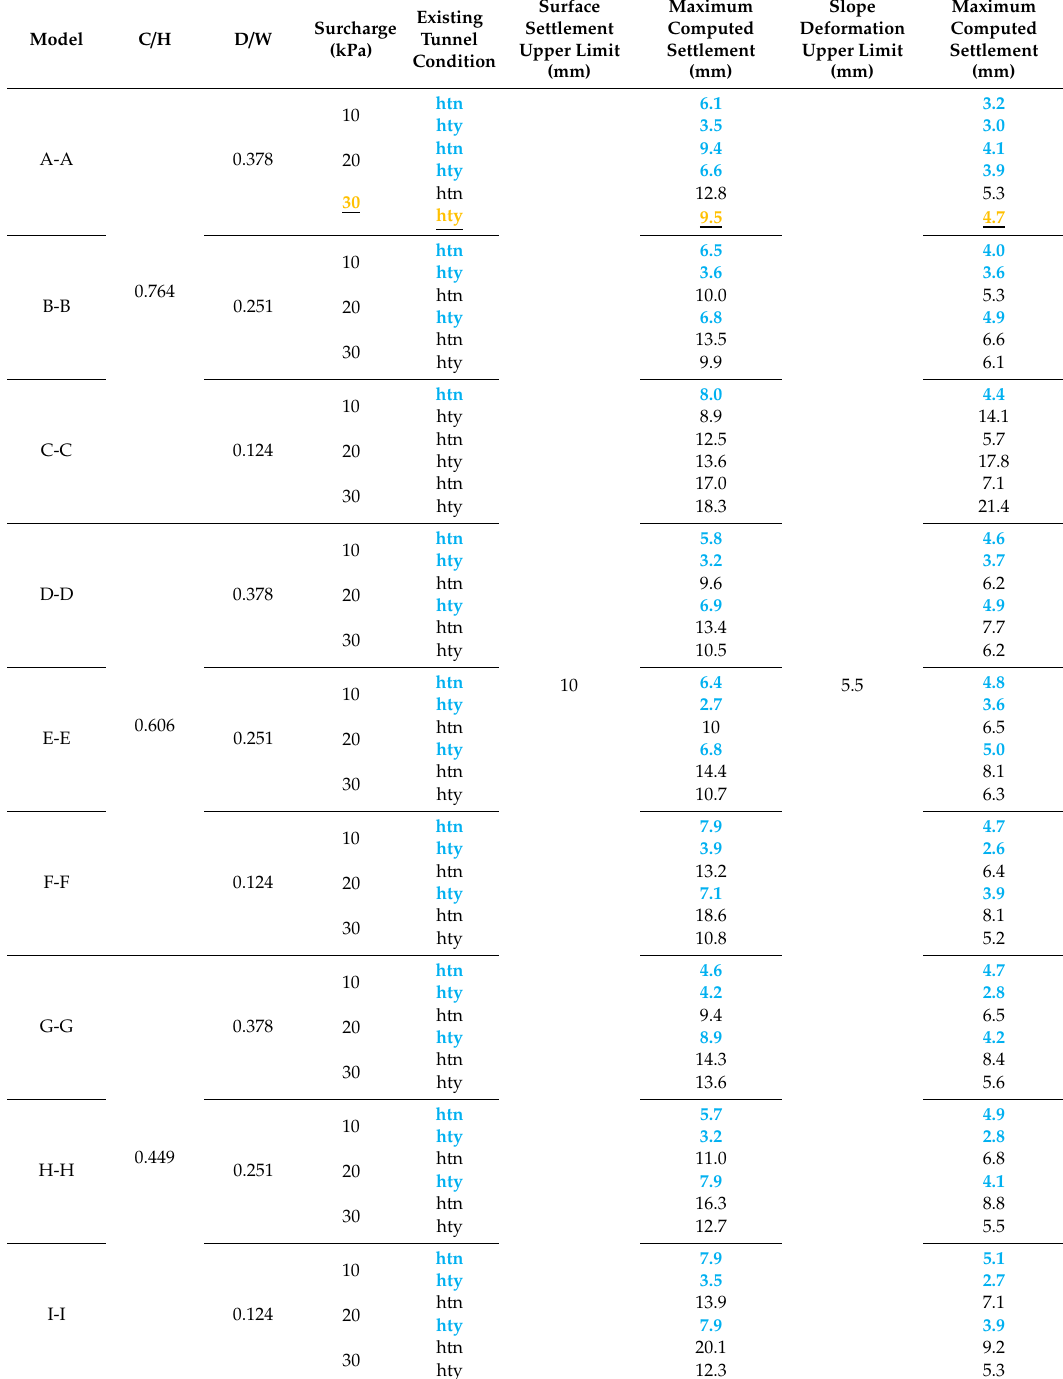
Table 6. Summary of the displacement calculations for all